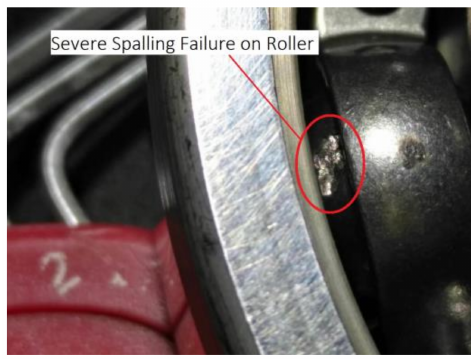
Figure 15. Severe peeling failure in one bearing ball after running for about 161 h.